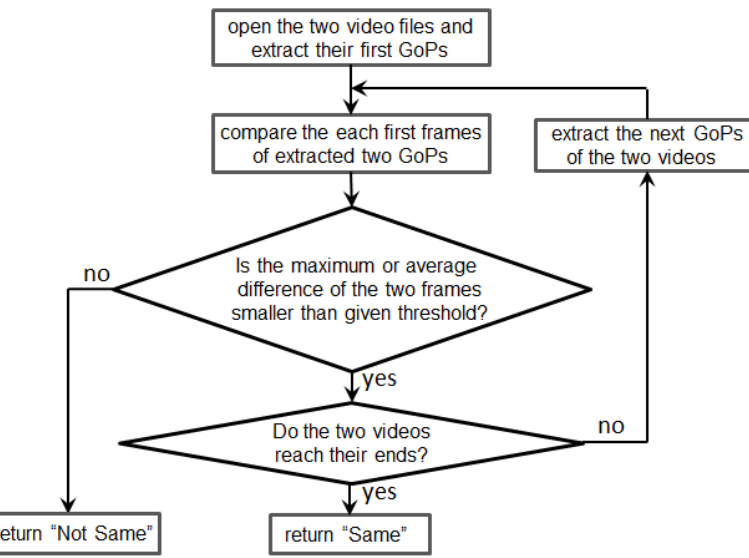
Figure 5. Flow chart of comparison procedure.